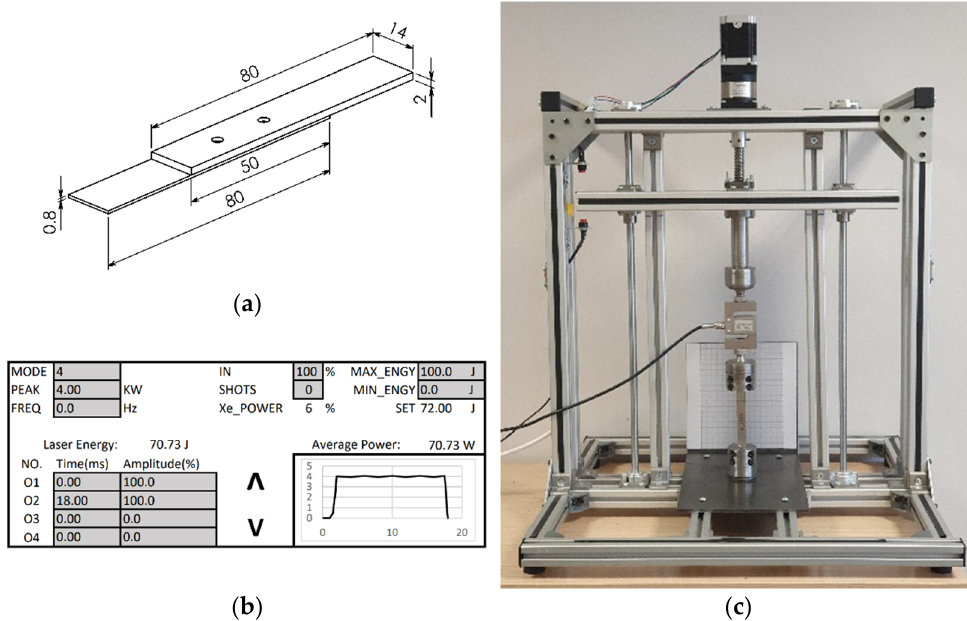
Figure 3. ( a ) Dimensions of test specimens and welding of 2 mm and 0.8 mm 304 series stainless steel test specimens from two points. ( b ) Laser welding parameters and signal form. ( c ) Photograph of the custom ‐ made benchtop tensile test device with a test specimen.